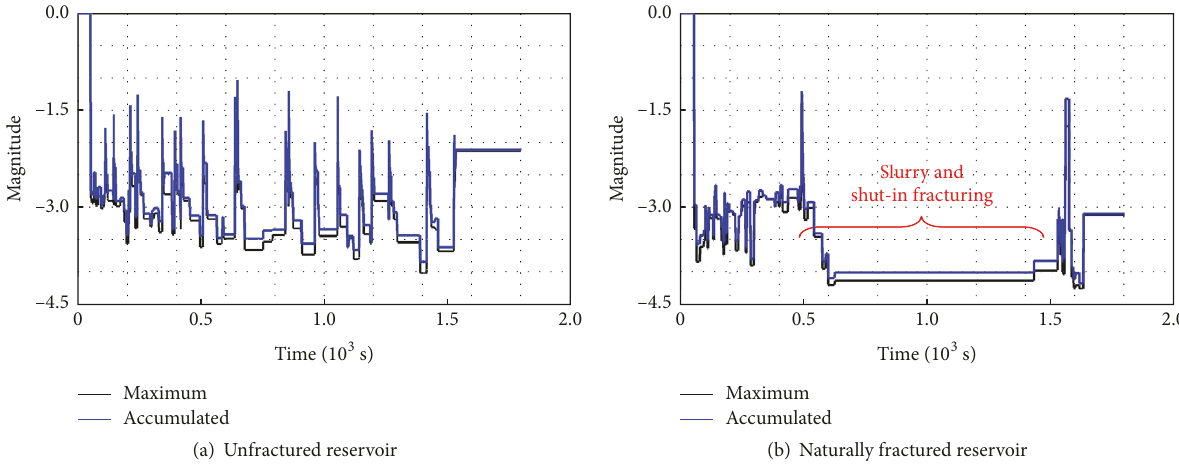
Figure 8: Evolution of maximum magnitude and accumulated magnitude of damaged